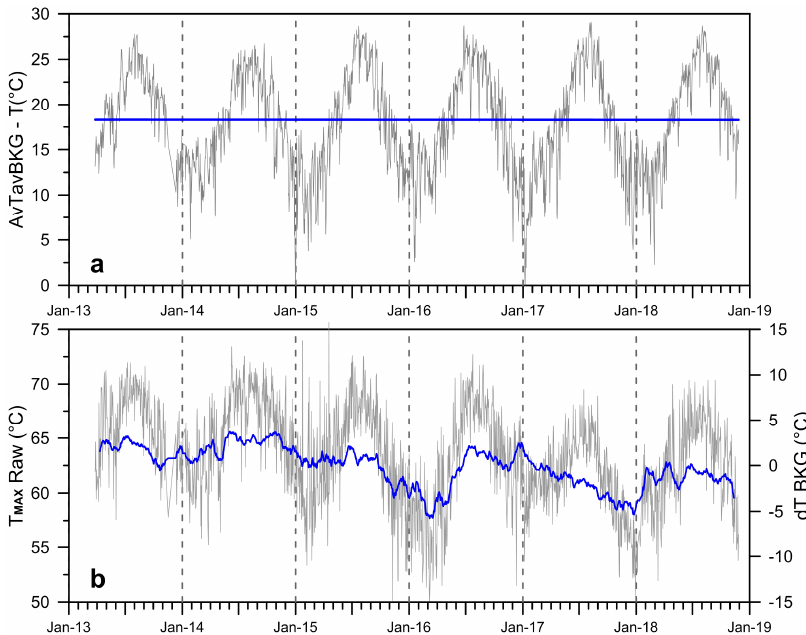
Figure 4. ( a ) Time-series of average temperature values of Pisciarelli background area (grey color) and linear regression fit (blue color); ( b ) the results of the background removal procedure applied to Pisciarelli station: RAW maximum temperature of IR scene (grey color) and residual temperature value dT (blue color).